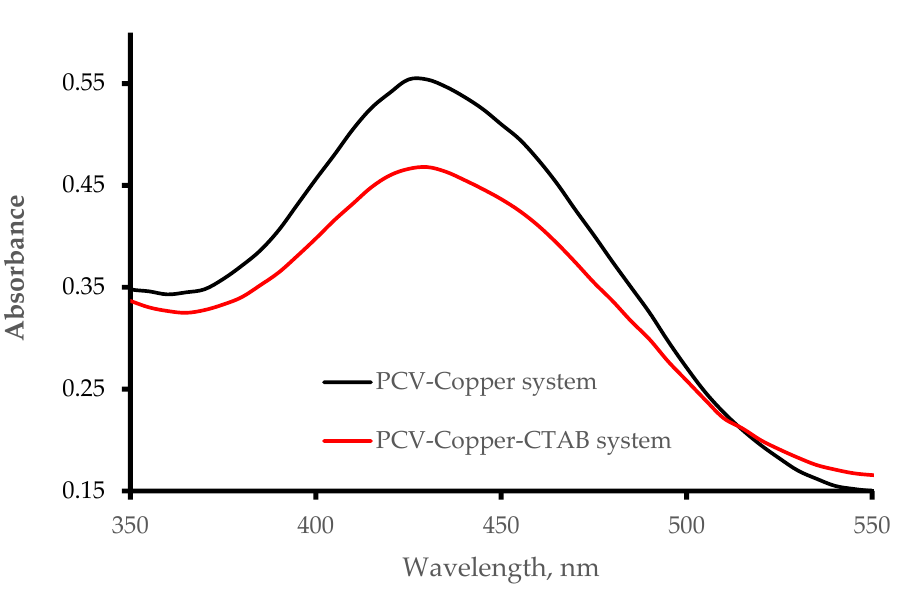
Figure 4. Absorption spectra measured under static mode: 0.15 mmol L − 1 PCV and 0.15: 0.15 mmol L − 1 of Cu-PCV and after addition of 5.0 µ g mL − 1 (1.4 × 10 − 2 mmol L − 1 ) CTAB 10 µ g mL − 1 (2.7 × 10 − 2 mmol L − 1 ) CTAB.